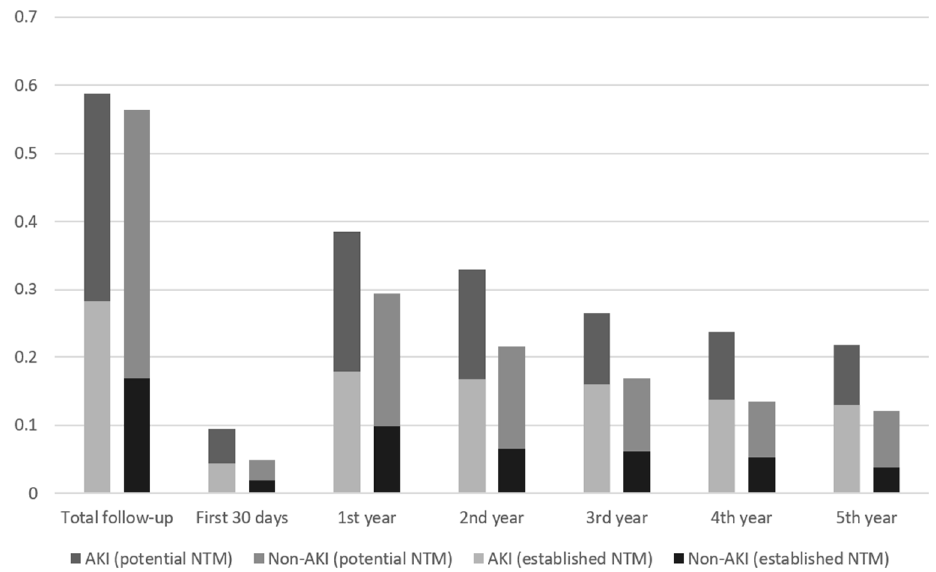
Figure 2. Percentages of AKI and non-AKI Patients Receiving ≥ 3 Nephrotoxic Medication Prescrip- tions by Year Since PICU Discharge. Bar chart of proportions of AKI and. Non-AKI patients who received ≥ 3 nephrotoxic medication prescriptions by year since PICU discharge. Numbers above figure bars represent the total number of participants with continuous follow-up at the time interval after discharge (denominator).